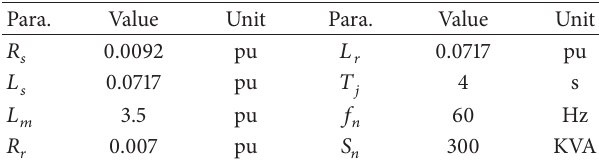
Table 1: Wind generator parameters.